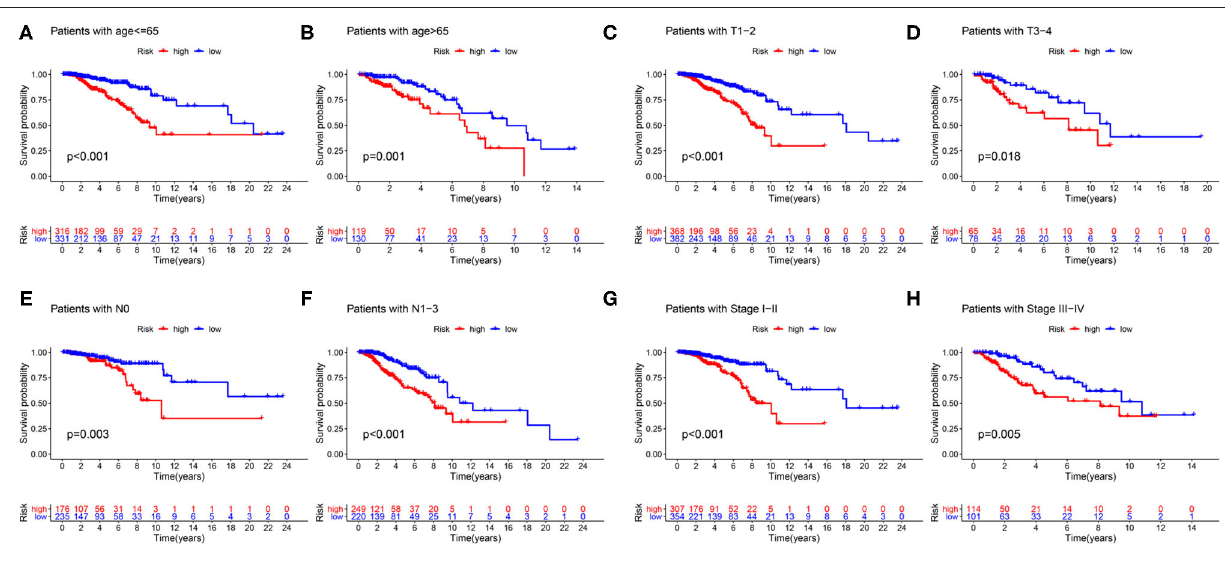
to the different groups of patients. Nevertheless, among